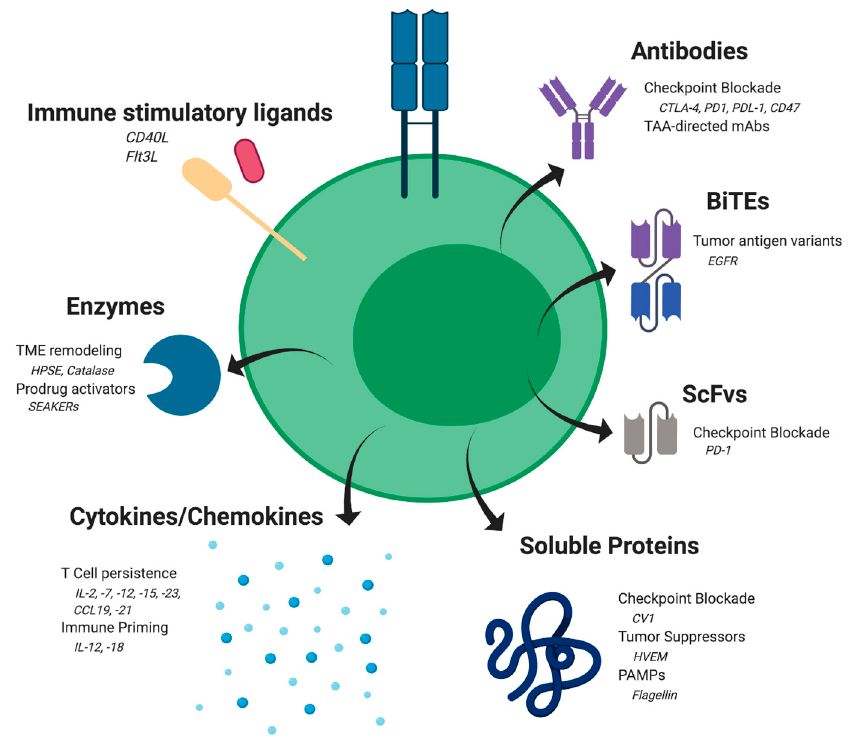
Figure 1. Therapeutic cargo delivered by TCMs.